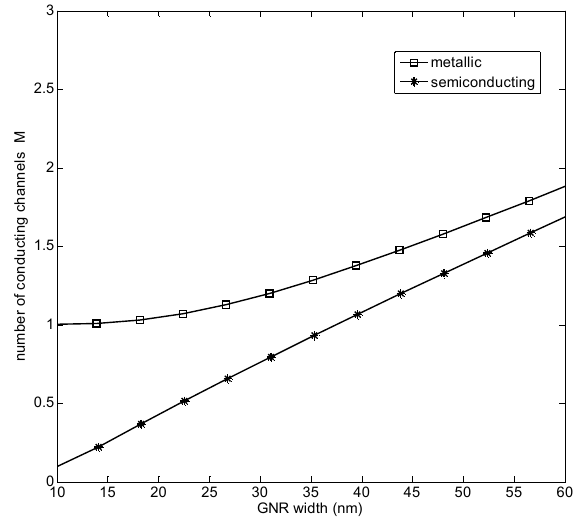
Figure 6. Equivalent number of conducting channels for metallic and semiconducting armchair graphene nanoribbons (GNRs) at 300